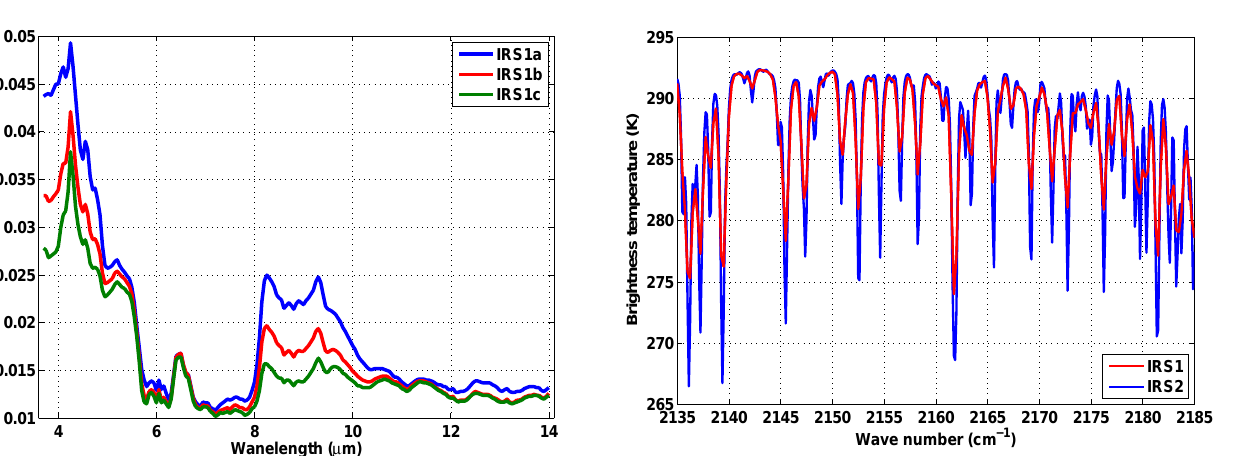
Figure 10. Impact of radiometric noise on the retrieval of surface spectral emissivity: standard deviation of retrieved emissivity for IRS1a-IASI (blue), IRS1b (red), IRS1c (green).